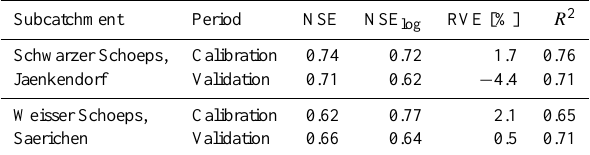
Table 1. Quality criteria for model calibration and validation.